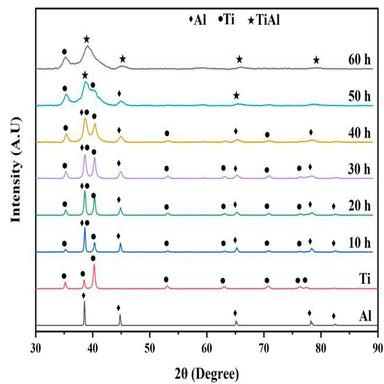
XRD plot of the powders before and after various hours of MA.